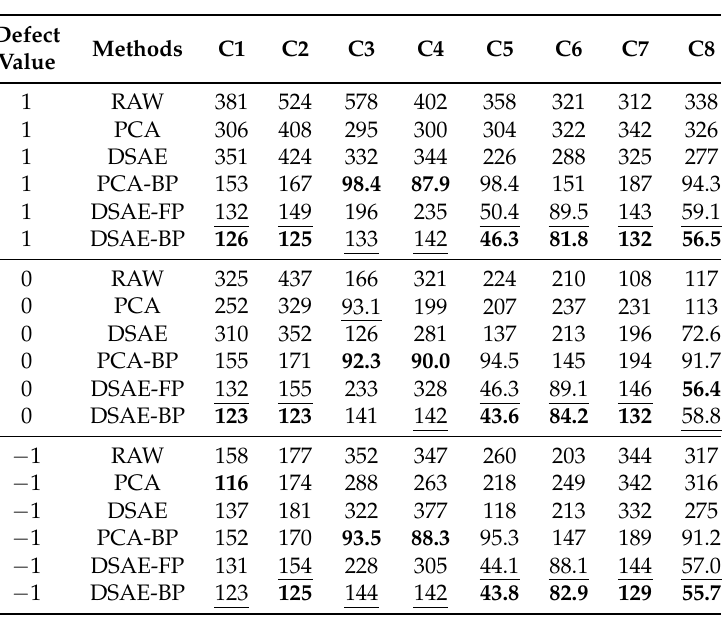
Table 5. Average segmentation distances between D12 and C1 to C8 with defect values of 1, 0, and − 1. The shortest average segmentation distance (best performance) is shown in bold font; the second shortest average segmentation distance is shown in